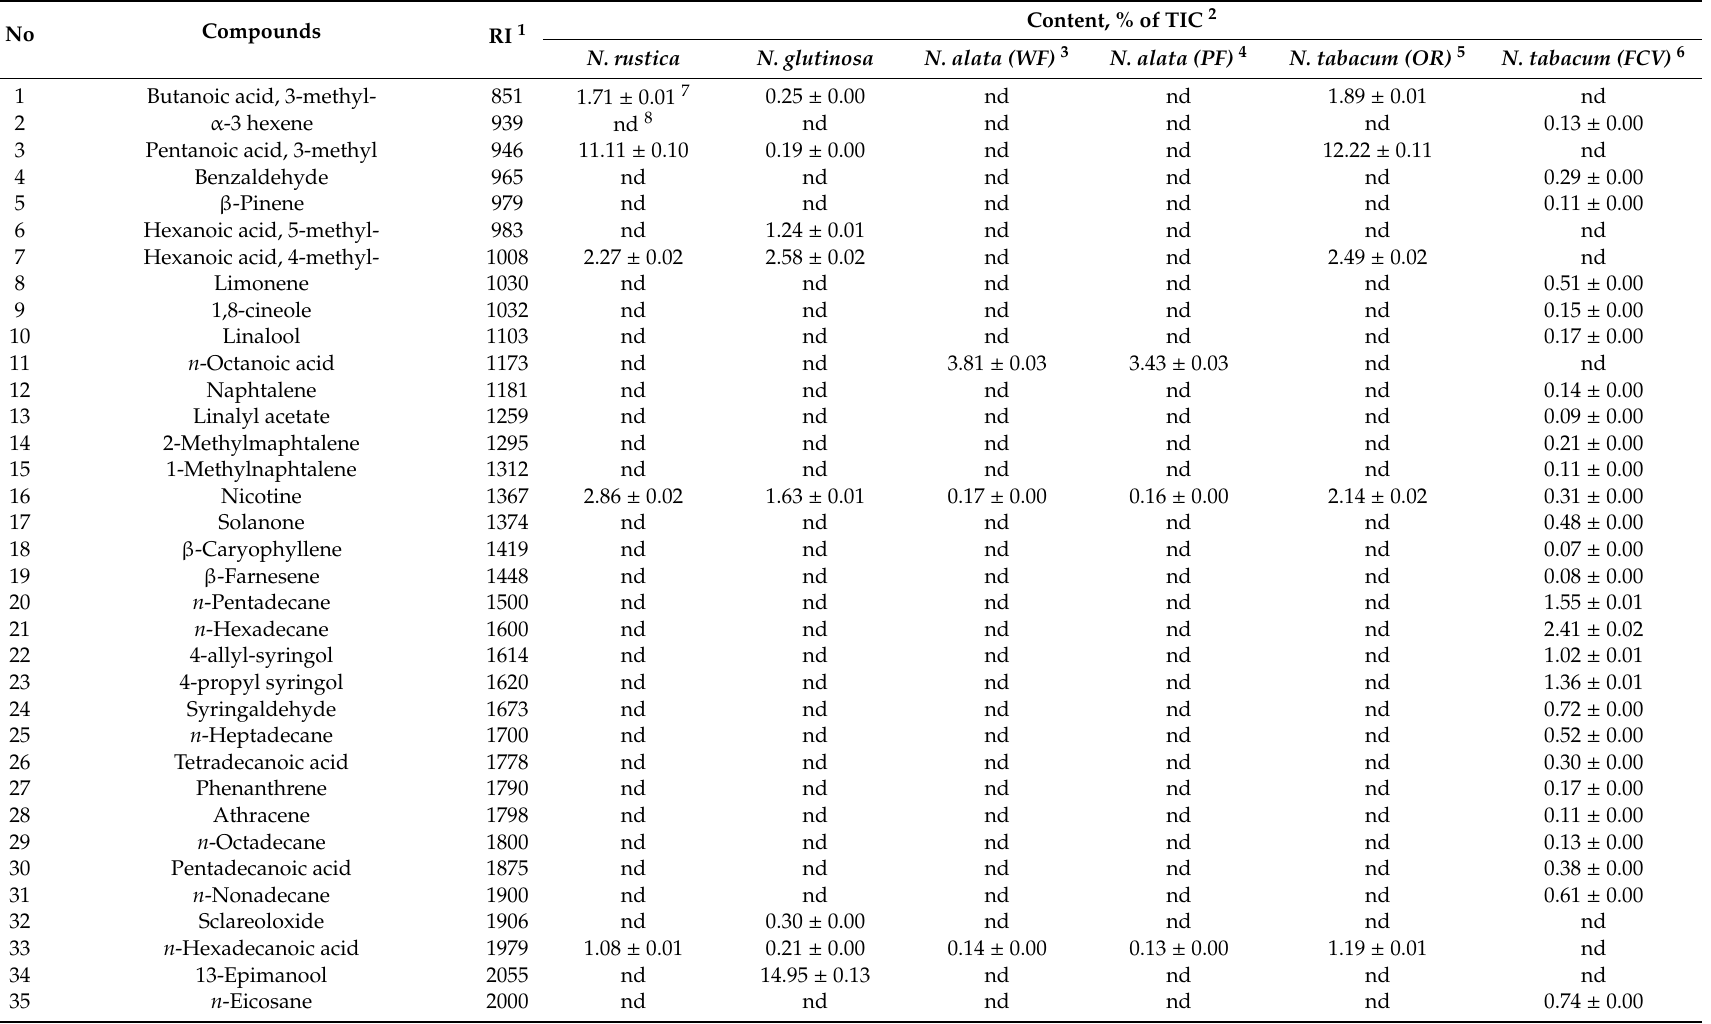
Table 3. Volatile composition (GC-MS) of Nicotiana flower